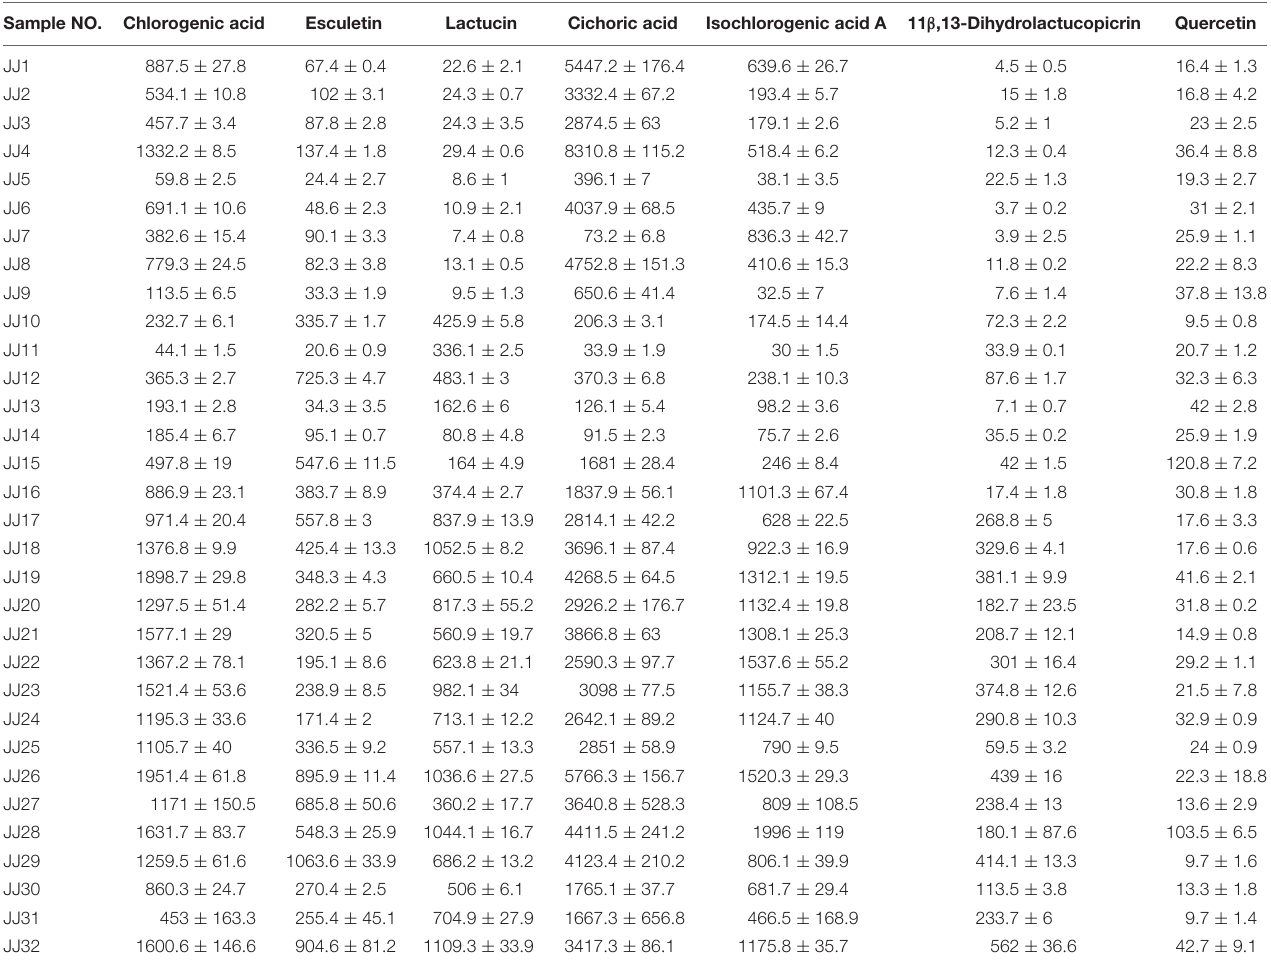
TABLE 2 | Content characteristics of seven compounds in above-ground parts of Cichorium intybus L. (mean ± SD, µ g/g). Sample NO. Chlorogenic